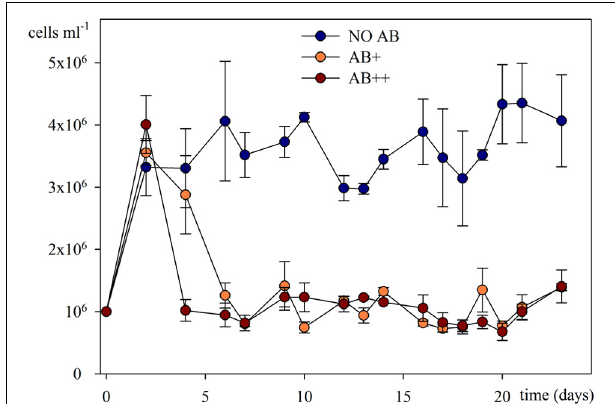
FIGURE 2 | Bacterial abundances in continuous culture vs. time. Overall bacterial numbers are given as mean of three replicates ( ± SD ) for each of the three treatments.